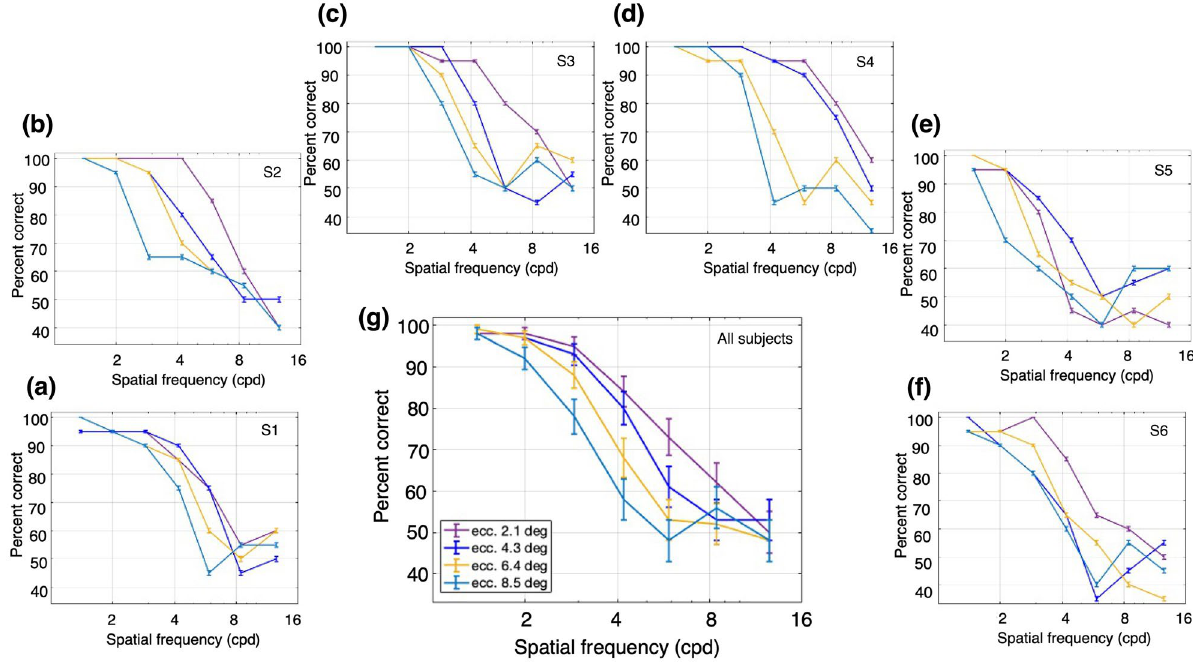
Figure 6. Performance for luminance modulation (LM) stimuli at different retinal eccentricities and a fixed TF of 20 Hz. The stimuli consisted of a luminance grating at different SFs and a fixed TF. The task was to discriminate the direction of motion of the grating when presented at different retinal eccentricities. Percent correct responses were measured while varying SF within blocks for different eccentricities: dark purple, fixation at 2.1°; dark blue, 4.3°; yellow, 6.4°; and light blue, 8.5°. ( a – f ) Percent correct responses for subjects 1 (S1) through 6 (S6). ( g ) Mean percent correct responses of the six subjects. Error bars represent the binomial SE of each condition for each subject ( a – f ) and the SEM (N = 6 subjects) for the subject-averaged results ( g the log SF acuity on the TF and stimulus type (LM or CM) as well as their interaction. A significant main effect of TF was observed, F (1,41) = 9.45, p = 3.7 × 10 −3 , as well as a significant interaction between TF and stimulus type, F(1,41) = 5.85, p = 0.02, such that SF acuity declined faster with increasing TF for LM stimuli (b = -0.04) than CM stimuli (b = − 0.005). Experiment 2: Spatial frequency dependence at different eccentricities. Based on previous reti- nal neurophysiology 9 , we further hypothesized that direction discrimination performance for CM stimuli would remain relatively constant as a function of stimulus eccentricity if the envelope motion was computed from the output of nonlinear Y-like cells rather than linear mechanisms. To test this prediction, we performed a second experiment in which direction discrimination performance for CM stimuli was measured as a function of car- rier SF, with a fixed carrier TF, at different eccentricities. Similar to Experiment 1, we compared the results to those with LM stimuli over the same values of SFs, TFs, and retinal eccentricities. For LM stimuli, previous find- ings would predict a systematic fall-off of performance for higher SFs at increasing eccentricities 32,33 . In each stimulus presentation of 250 ms duration, an LM or CM stimulus was presented in the center of the screen while the subject fixated a target that was 2.1°, 4.3°, 6.4°, or 8.5° away from the stimulus (Fig. 2a,d). The task was to report the direction of motion of the LM grating or of the CM envelope. Different eccentricities were tested in separate trial blocks. Within each block, the SF of the LM grating or the carrier SF of the CM stimulus was varied using the method of constant stimuli with a fixed TF (for LM stimuli) or carrier TF (for CM stimuli) of 20 Hz, respectively. This high value of TF or carrier TF was specifically chosen to minimize the contribution of linear (luminance-based) mechanisms, based on the results of the previous section. Furthermore, for the CM stimuli, the envelope TF was fixed at 3 Hz. This low value was chosen based on the envelope TF tuning of LGN Y-cells which closely match the TF tuning for contrast-reversing gratings 16 that are widely used to characterize Y-like nonlinearities 8,9,15 . In stark contrast to their low envelope TF preferences, Y-cells often respond best to higher carrier TFs (at least as high as 20 Hz), and the preferences for the two TFs are not significantly correlated 17 . As in Experiment 1, the LM stimuli (vertical gratings, drifting leftwards or rightwards) were presented with a Michelson contrast of 5%. Percent correct performance to report the direction of motion of the grating as a function of SF is plotted for one subject in Fig. 6a for each of a series of eccentricities. Note that the performance declined with SF, and the high-SF fall-off decreased with stimulus eccentricity. Figure 6b–f plots the results for These interpretations were confirmed with a 2-way ANOVA (Fig. 6g), showing a significant main effect for SF,